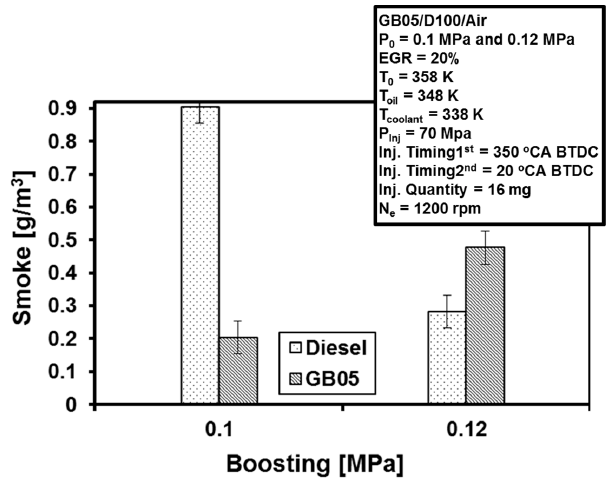
Figure 13. Effect of intake boosting on NOx emissions in MPCI mode.